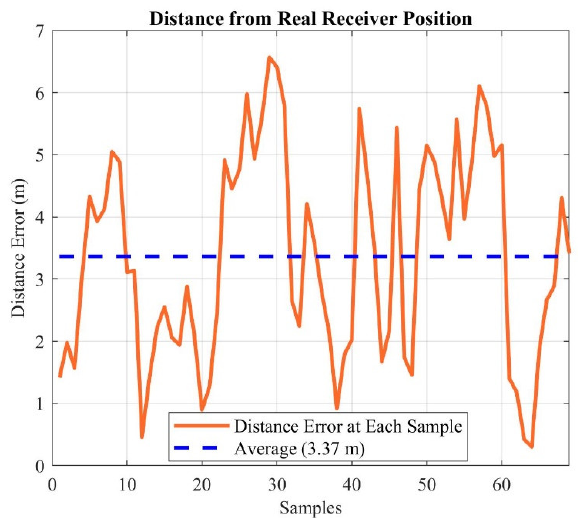
Figure 16. Distance from the real position for each of 69 points.